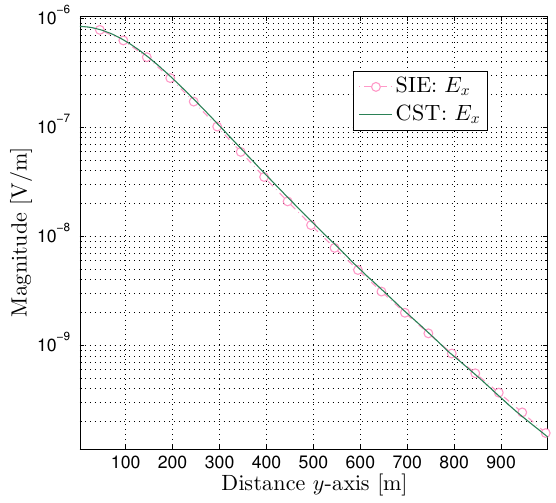
Figure 6. Electric field in the x -direction component at test point ( 0, y , − 500 ) .